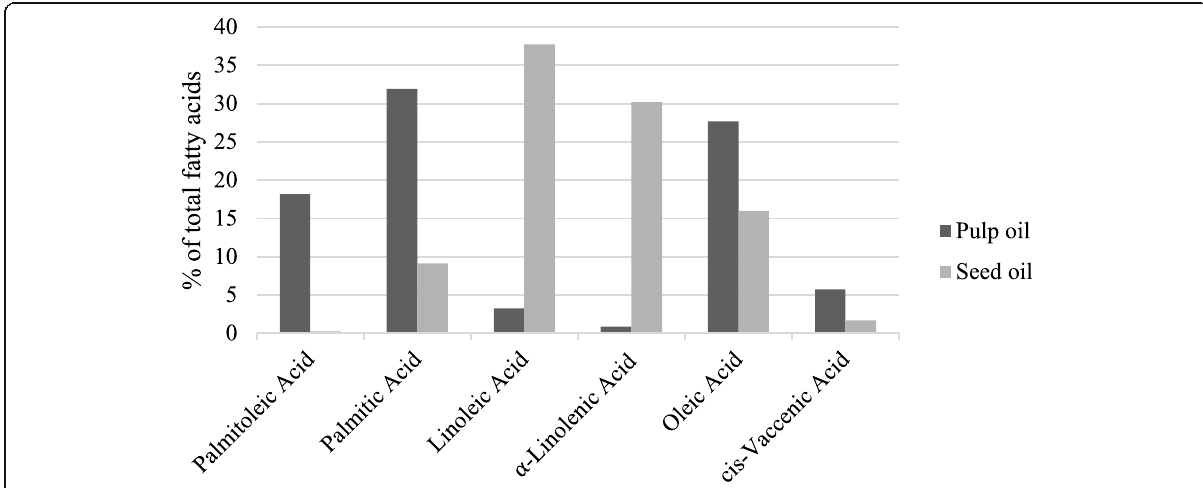
Fig. 2 Graphical representation of specific saturated and unsaturated fatty acids presents in sea buckthorn oils, adapted from Dulf